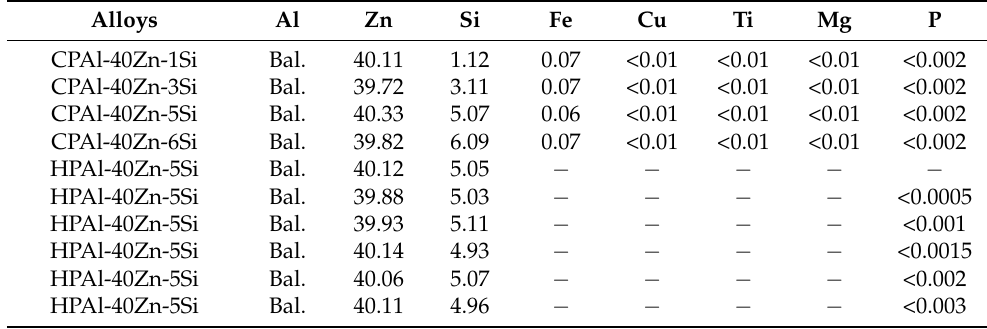
Table 1. Chemical compositions of commercial-purity (CP) Al-40Zn-xSi and high-purity (HP) Al- 40Zn-5Si (wt.%) alloys.